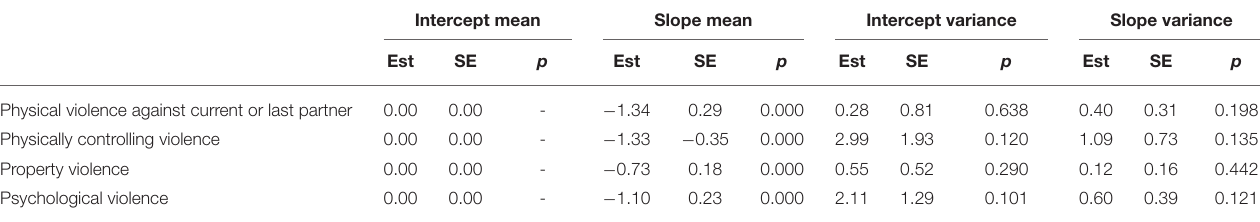
TABLE 2 | Unstandardized estimates (Est) and standard errors (SE) of means and variances of parameters of linear growth models of self-reported violence a ( n = 84). Intercept mean Slope mean Intercept variance Slope variance